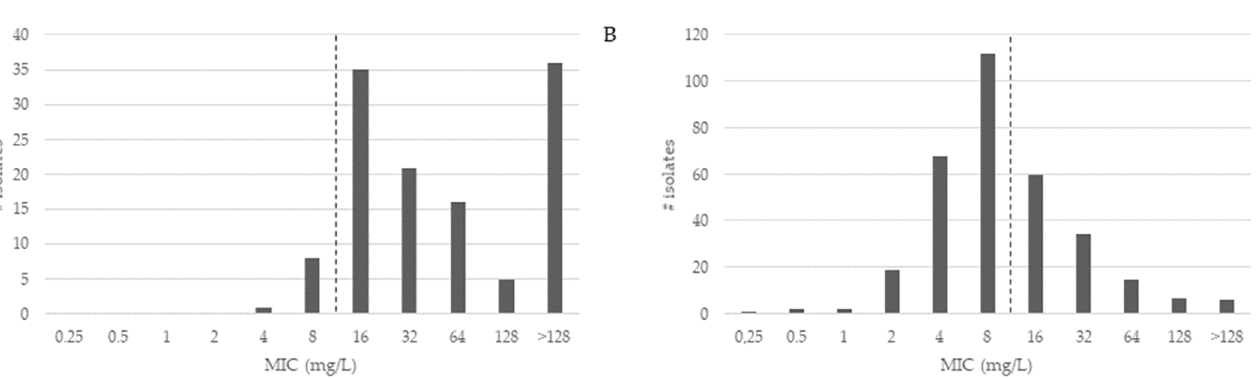
Figure 1. Distribution of antibiotic minimum inhibitory concentrations (MICs) for ceftazidime-avibactam of meropenem-resistant Pseudomonas aeruginosa isolates. For antimicrobial susceptibility testing purposes, the concentration of avibactam was fixed at 4 mg/L. The pointed line depicts the CZA-resistance breakpoint (susceptible ≤ 8). ( A ) shows the MIC distribution for MBL-positive isolates; ( B ) shows the MIC distribution for MBL-negative isolates.